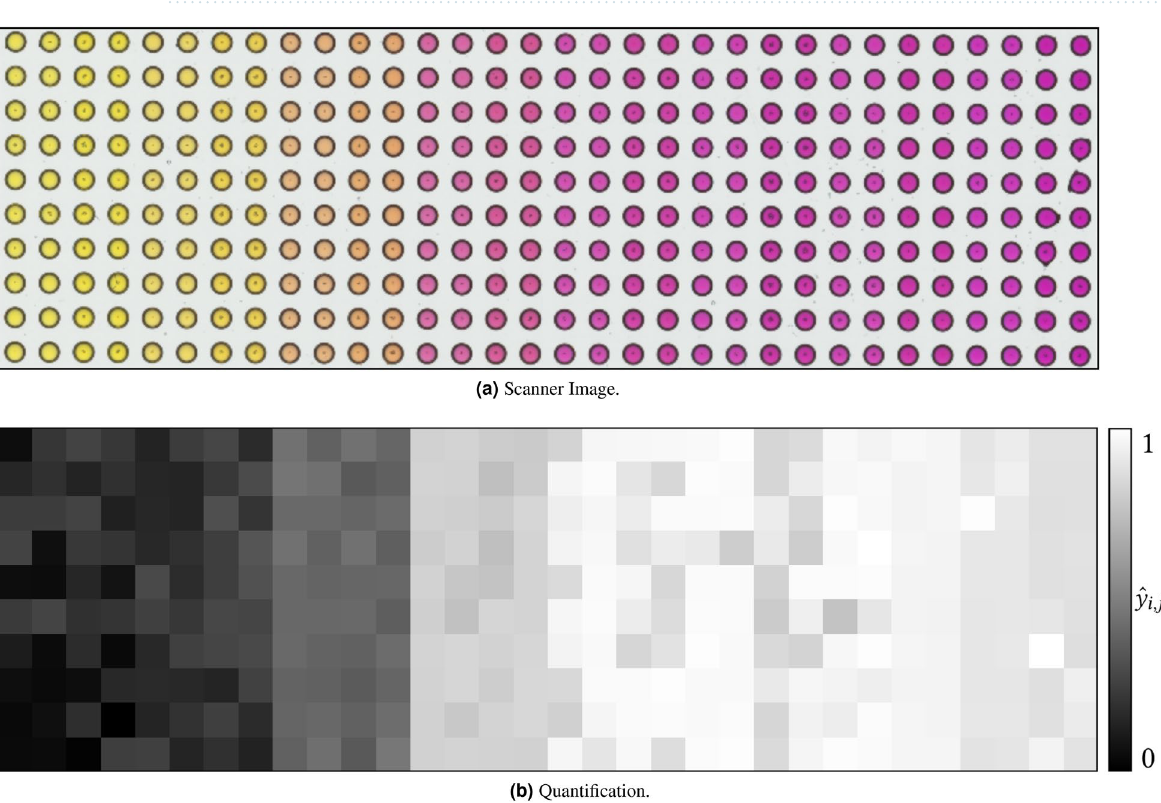
Figure 13. Colorimetric Analysis. An exemplary scanner image ( a ) and the corresponding quantification ˆ y i , j ( b ) are